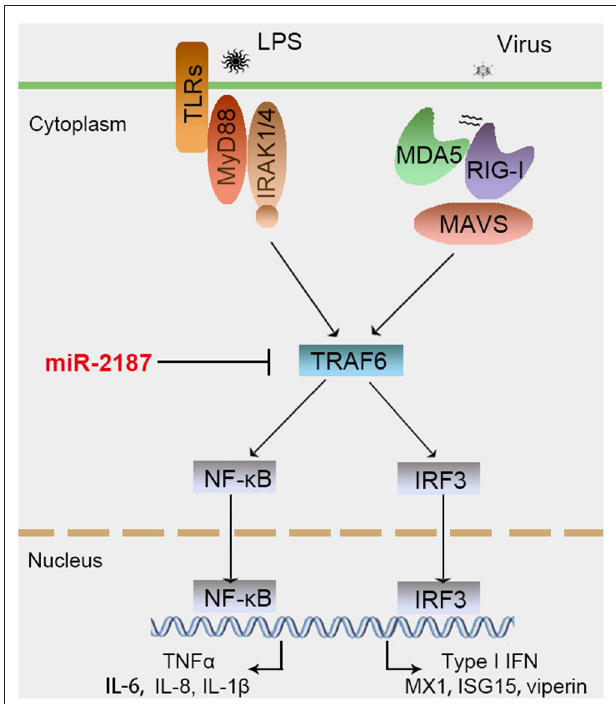
FIGURE 9 | Proposed model for the mechanism by which induced miR-2187 negatively regulates NF- κ B and IRF3 signaling expression by targeting TRAF6, thereby avoiding excessive inflammation and immune